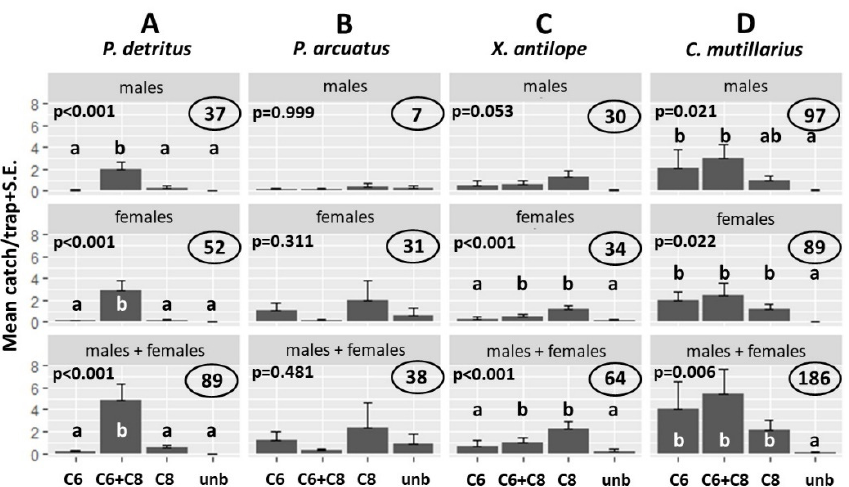
Figure 4. Means (+S.E.) of Plagionotus detritus ( A ), Plagionotus arcuatus ( B ), Xylotrechus antilope ( C ) and Clerus mutillarius ( D ) male and female specimens captured in traps baited with racemic 3-hydroxyhexan-2-one (C6), ( S )-2-hydroxyoctan-3-one (C8), the combination of the two compounds, or unbaited controls. Columns with the same letter within a diagram are not significantly different at P = 0.05 by Kruskal–Wallis, followed by Wilcoxon non-parametric tests. P values in the upper left corner is a diagram show Kruskal–Wallis results if not significant at P = 0.05. Numbers in ovals in the right upper corner of individual diagrams give a total number of beetles captured.